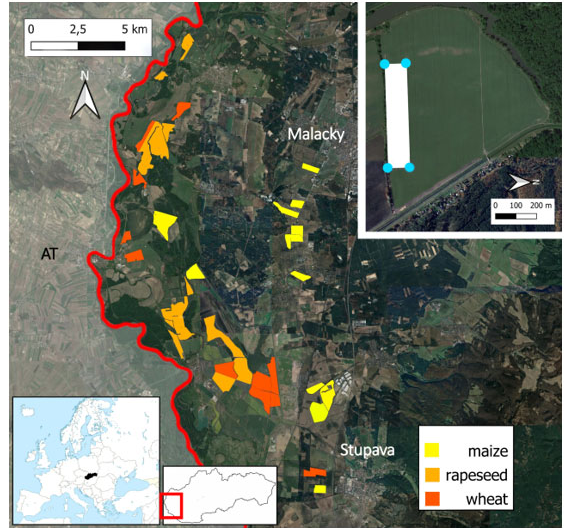
Figure 1. Location of the sampled arable fields (maize, rapeseed and wheat) in the study area (main map). Within each sampled field, a 500 × 100 m study site with four pitfall traps (blue circles) was established (upper right inset). The position of the study area in Slovakia and Slovakia in Europe is also shown (lower left insets).